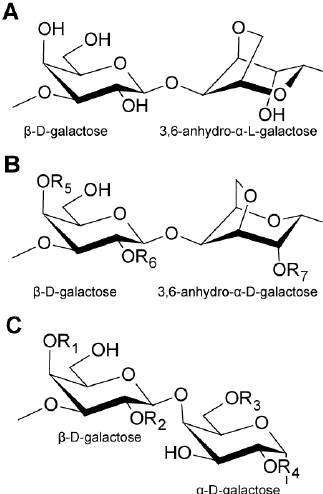
Figure 3. ( A ) Structure of the repeating disaccharide units in agarose; ( B ) structure of the repeating disaccharide units in kappa-carrageenan (R 6 = R 7 = H, R 5 = SO 3 − ), iota-carrageenan (R 6 = H, R 5 = R 7 = SO 3 − ) and theta-carrageenan (R 5 = H, R 6 = R 7 = SO 3 − ); ( C ) structure of the repeating disaccharide units in mu-carrageenan (R 2 = R 4 = H, R 1 = R 3 = SO 3 − ), nu-carrageenan (R 2 = H, R 1 = R 3 = R 4 = SO 3 − ) and lambda-carrageenan (R 1 = H, R 2 = R 3 = R 4 = SO 3 − ) [3].